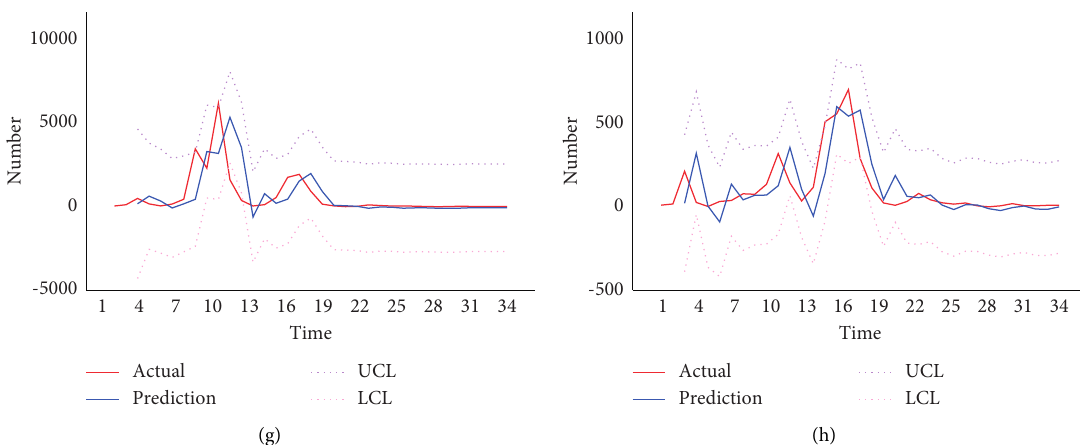
Figure 4: Actual and predicted values with ARIMA models in derivative topic. (a) Natural disaster 1. (b) Natural disaster 2. (c) Accident 1. (d) Accident 2. (e) Public health 1. (f) Public health 2. (g) Social security 1. (h) Social security